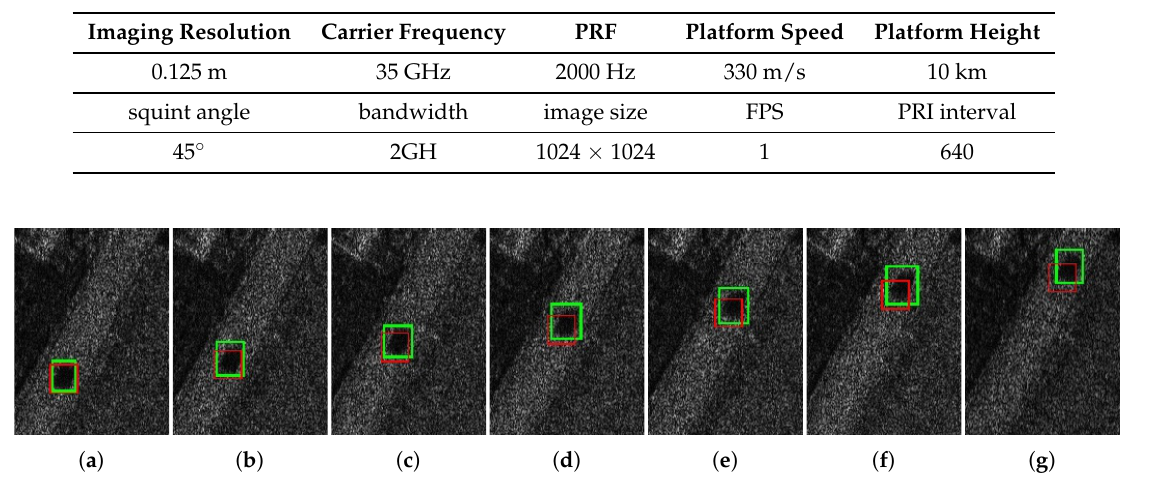
Table 1. Details about the simulated data used for testing the algorithms.